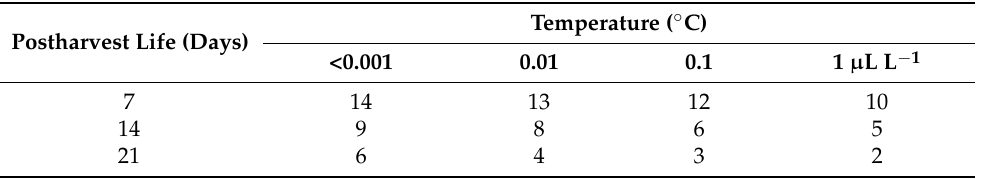
Table 1. The storage temperature of broccoli that allows specific postharvest life periods in the presence of specific ethylene